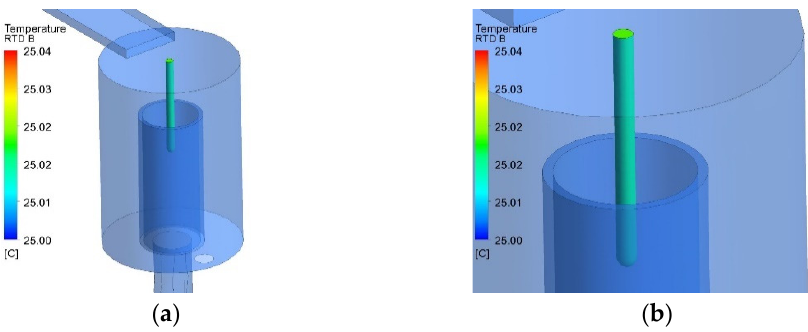
Figure 11. Temperature, low-pressure section: ( a ) Isometric view ( b ) RTD Sensor, zoom.